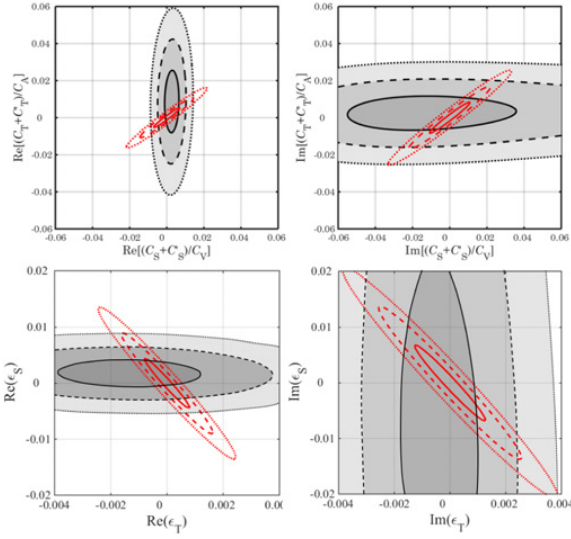
Table 1. Sensitivity factors for scalar and tensor couplings (leading order, no recoil, point charge). Calculations were performed with λ = − 1 . 272 and kinematical factor averaged over electron kinetic energy E from Ref. [7].